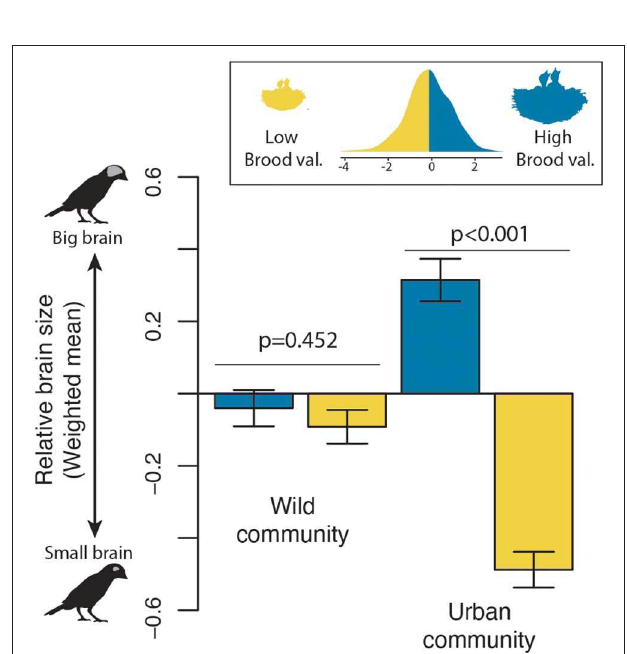
FIGURE 3 | Changes in the relative brain size of wild and urban bird communities. The community-weighted mean relative brain size of wild and urban communities is shown for both high (blue) and low (yellow) brood-value strategies, using the median of the brood value distribution as the breakpoint. P -values indicate the significance level from two-sample Weighted T -Tests (i.e., Welch